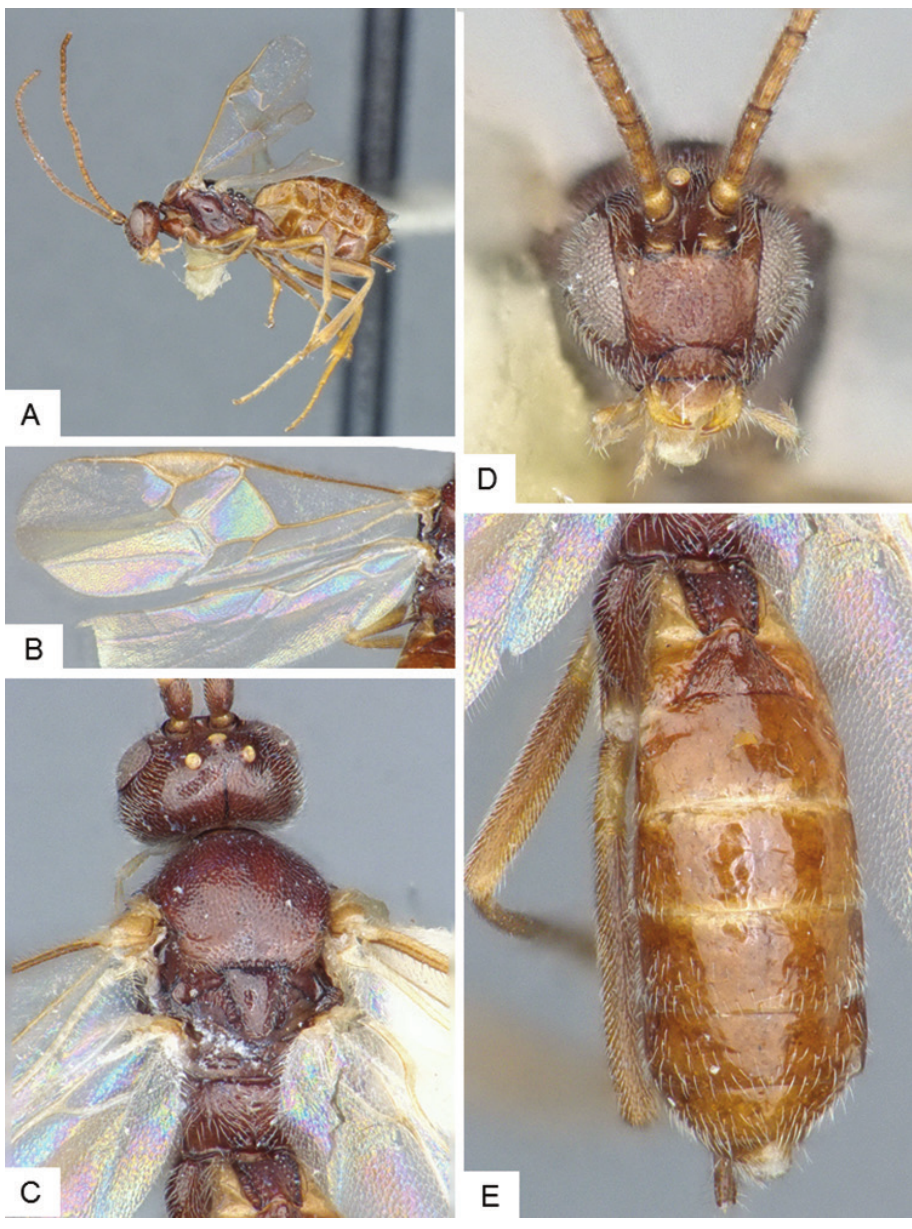
Figure 19. Glyptapanteles sp. 5. A Habitus, lateral B Fore wing and hind wing (partially) C Head and mesosoma, dorsal D Head, frontal E Metasoma,